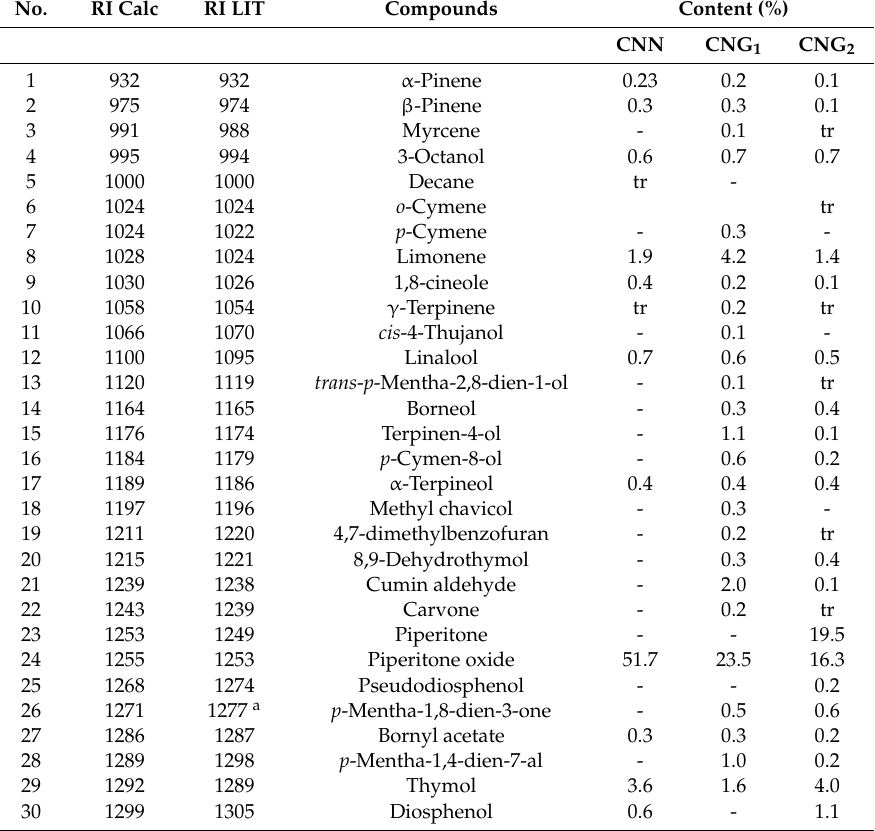
Table 2. Chemical profiles of essential oils obtained from Clinopodium nepeta subspecies harvested from di ff erent